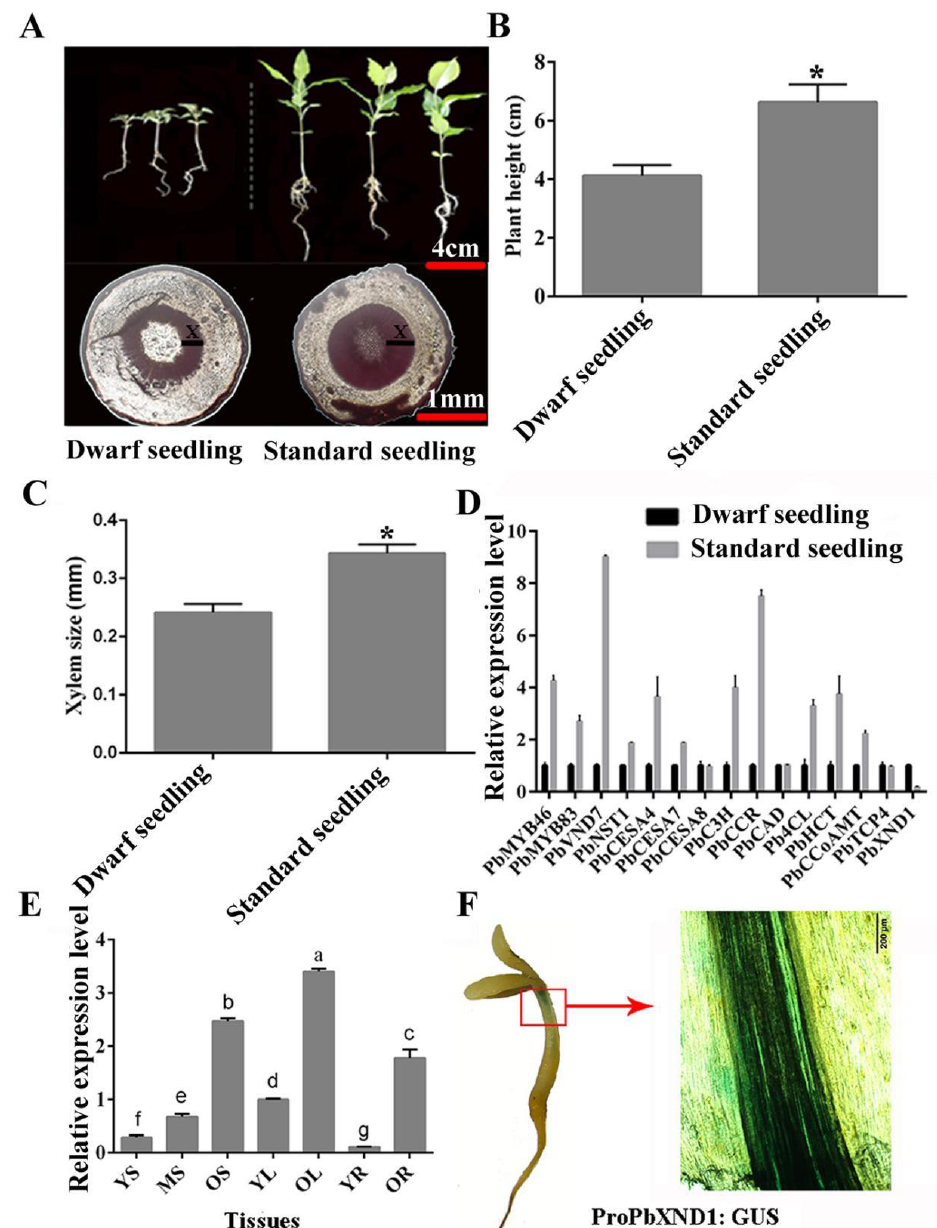
Figure 1. PbXND1 is closely correlated with xylem development. ( A ) ‘Red Zaosu’ filial generations and phloroglucinol-HCl staining of the stem. X, xylem. Bars, 4 cm and 1 mm. ( B ) Plant height of the dwarf hybrid seedling and standard hybrid seedling. Data are shown as means ± SD ( n = 25). Asterisks indicate significance levels. (*, p < 0.05). ( C ) Xylem size of the dwarf hybrid seedling and standard hybrid seedling. Data are shown as means ± SD ( n = 3). Asterisks indicate significance levels. (*, p < 0.05). ( D ) Relative expression of xylem-related genes in filial generations. Data are shown as means ± SD ( n = 3). ( E ) Expression levels of PbXND1 and PbTCP4 in different tissues and developmental stages. YL, young stem; ML, middle stem; OL, old stem; YL, young leaf; OL, old leaf; YR, young root; OR, old root. Data are shown as means ± SD ( n = 3). Different letters denote statistical significance ( p < 0.05). ( F ) Activity of the PbXND1 promoter in the pear vascular tissue. Bars, 200 µ